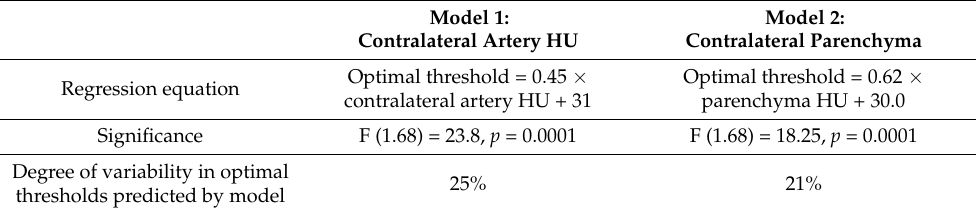
Table 1. Linear regression models to predict optimal thresholds that discriminate clot from normal tissue using contralateral artery HU (model 1) and contralateral parenchyma (model 2).